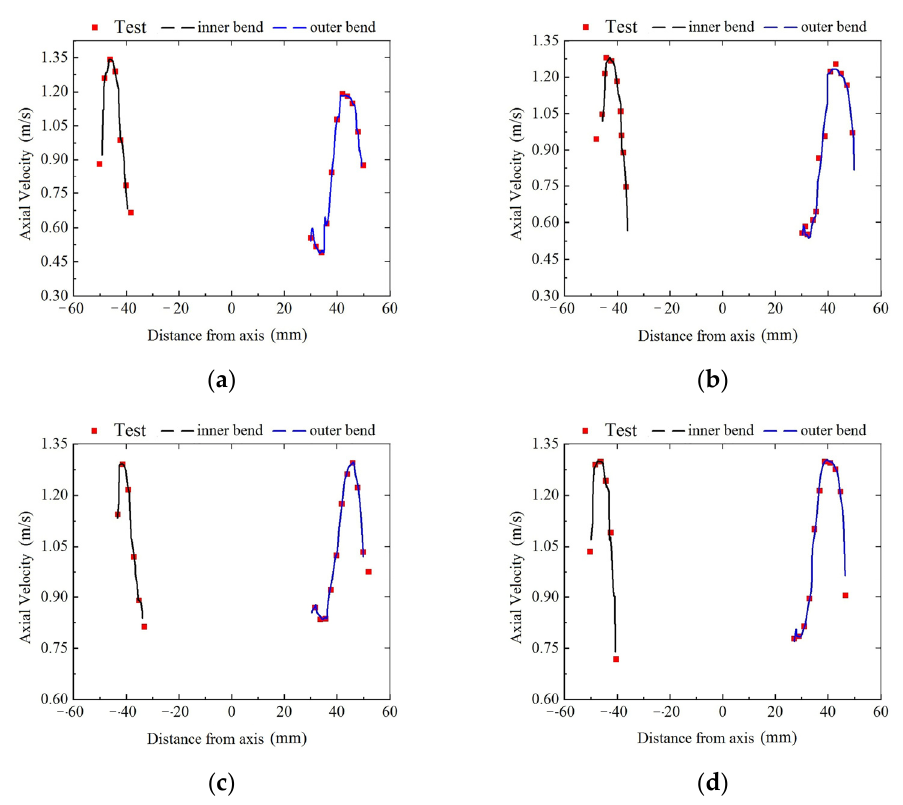
Figure 6. Comparison of simulation results and test results of the axial velocity of gap flow: ( a ) first condition θ = 22.5°; ( b ) second condition θ = 67.5°; ( c ) third condition θ = 112.5°; ( d ) fourth condition θ = 157.5°.